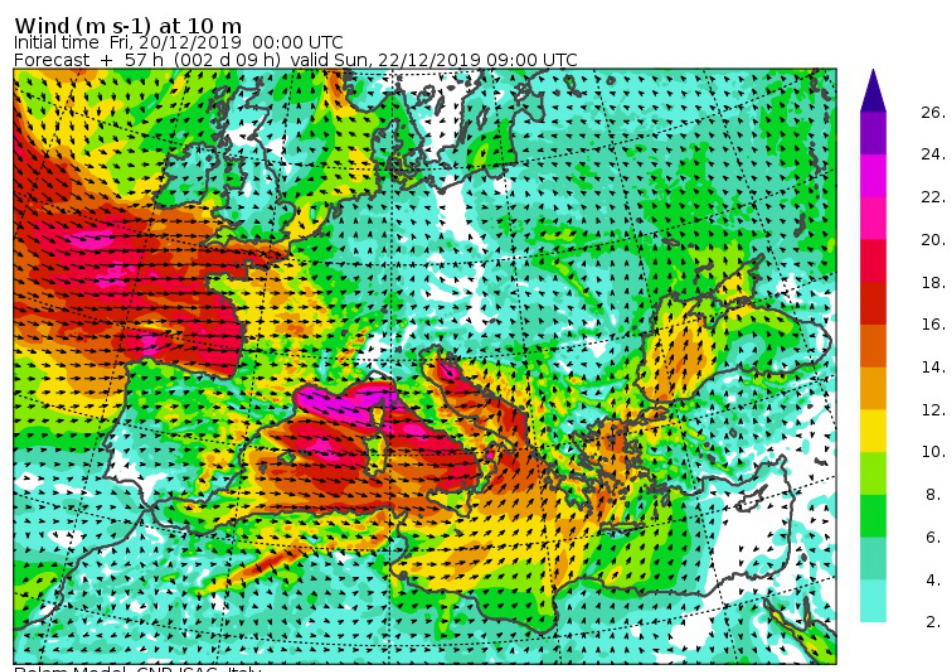
Figure A14. Map of the wind at 10 m height over the Mediterranean basin, as forecast for 22 December 2019 at 9 a.m. by the BOLAM model. The arrows indicate the wind direction and the wind speed is shown in the colour